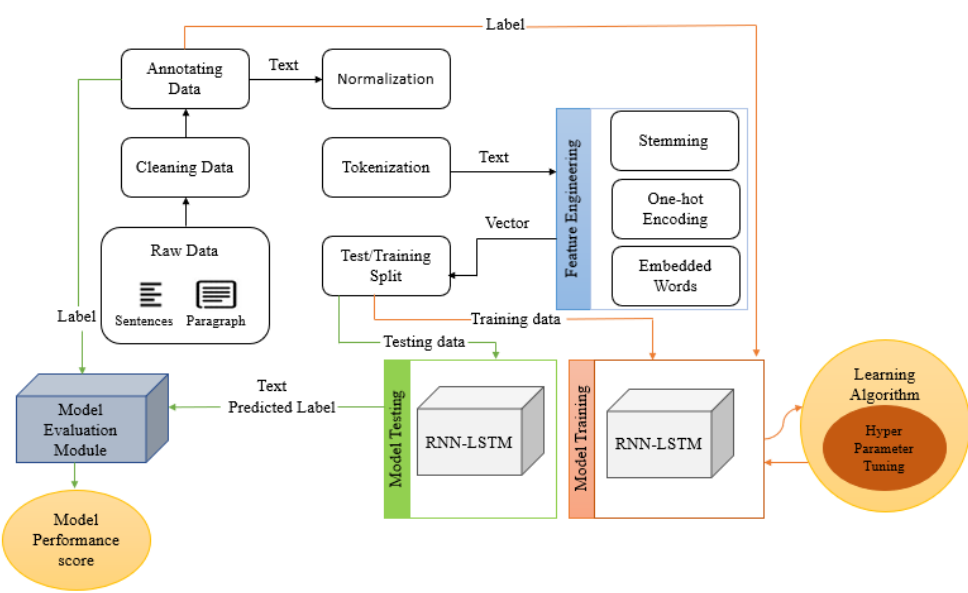
Figure 1. Procedure of Depression